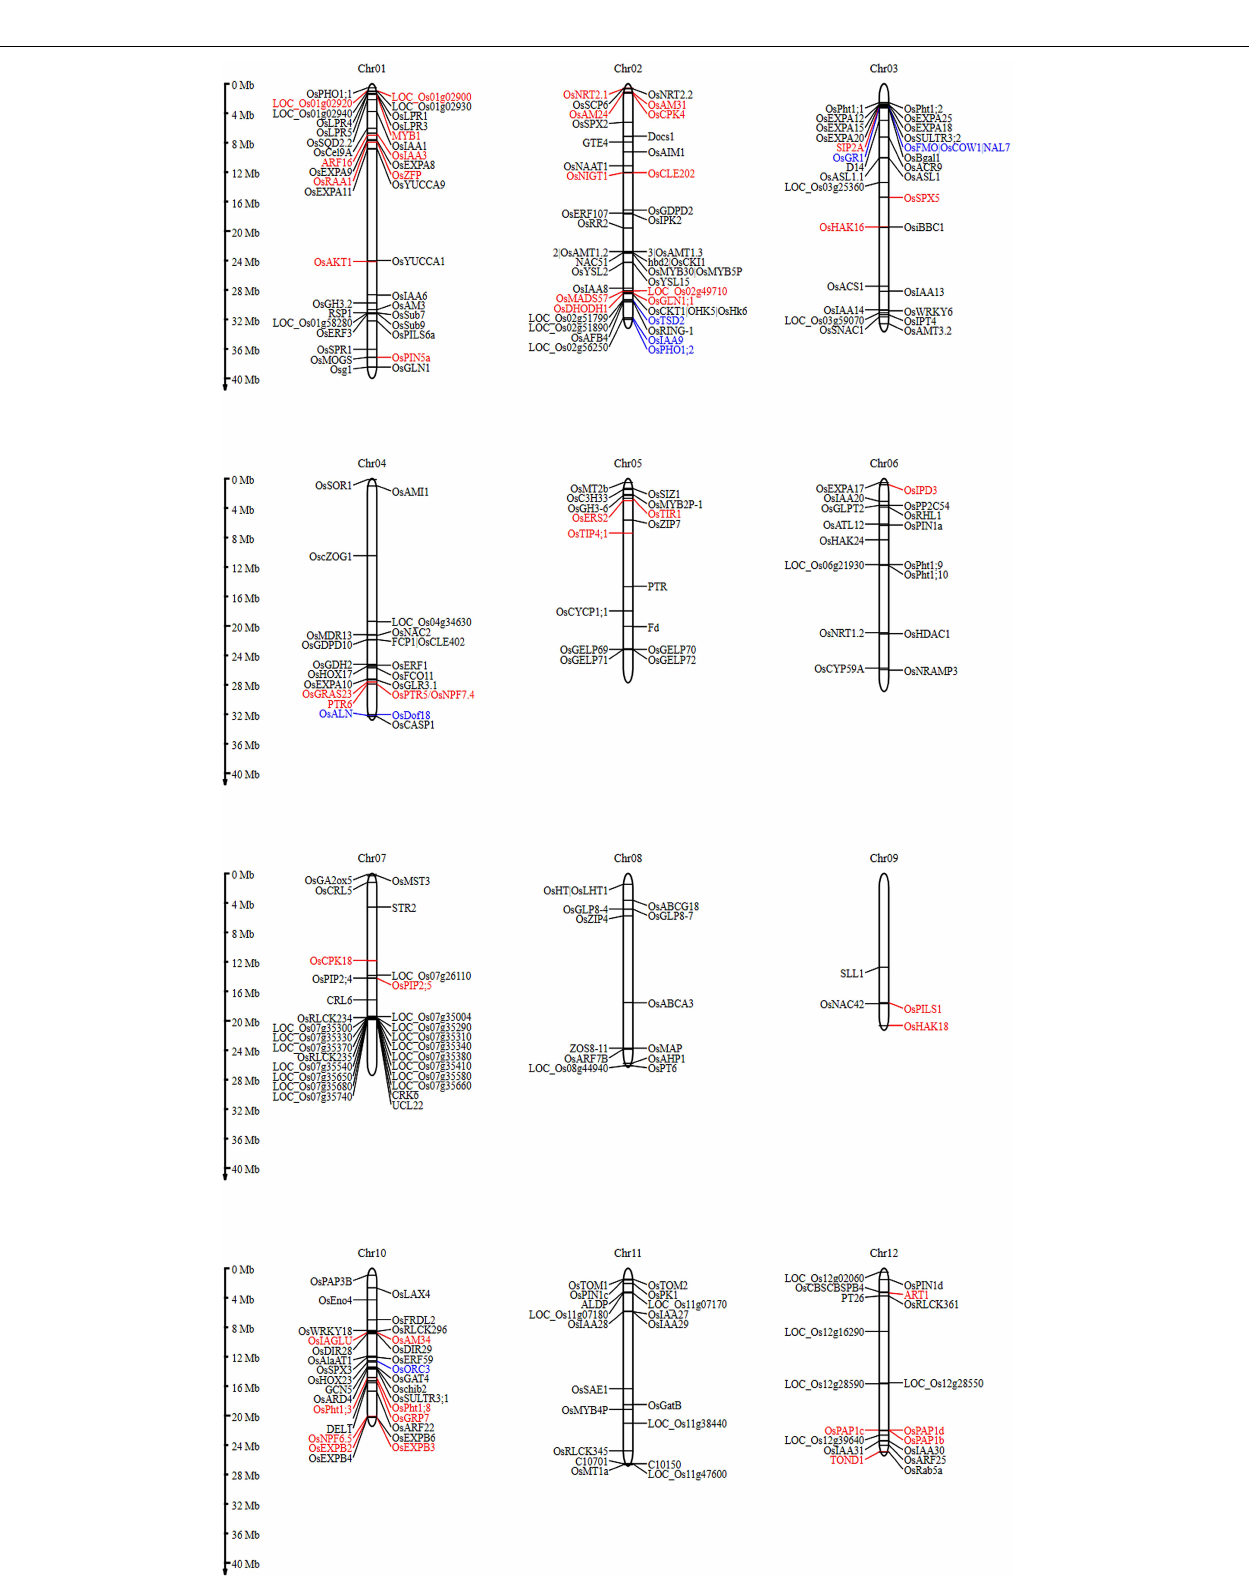
Frontiers in Plant Science |